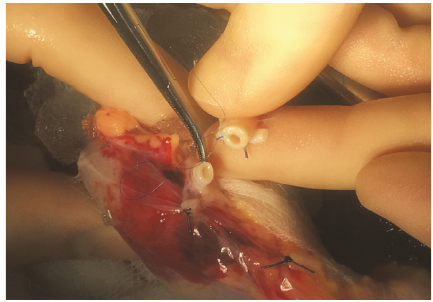
Figure 3: Start of the E-E anastomosis between tubulised aortic patch and polar renal artery.